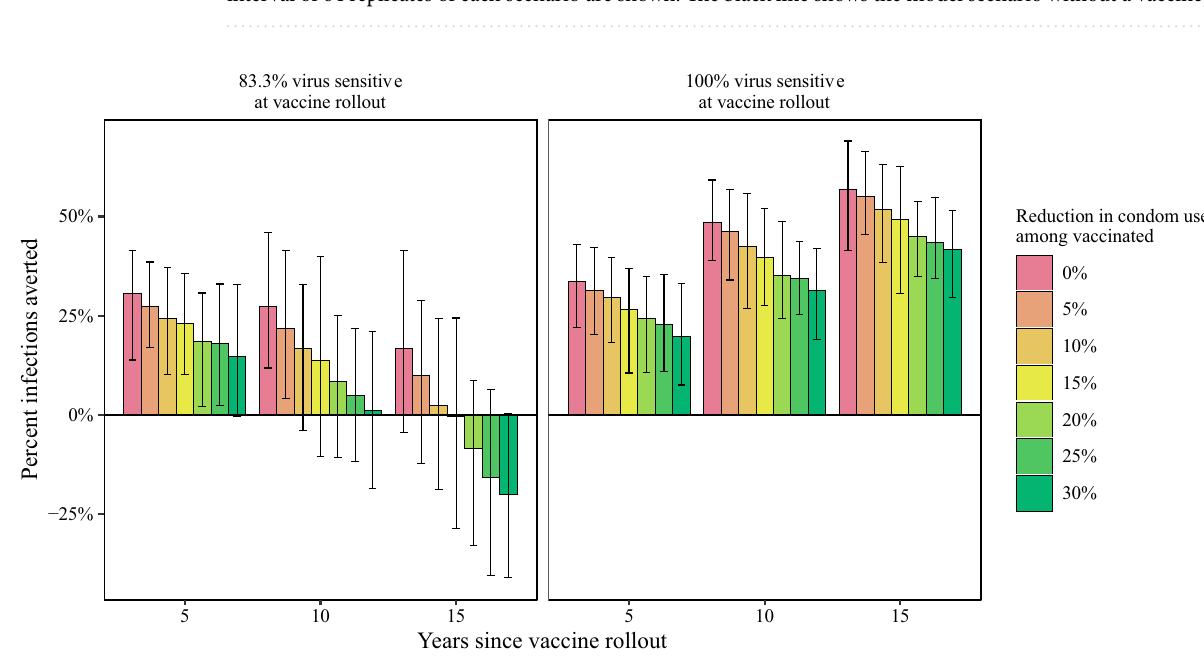
Figure 1. HIV-1 prevalence following introduction of a partially effective vaccine in the year 2018 (dashed vertical line), with 50% overall vaccine efficacy and 70% vaccine coverage (note that 50% overall efficacy can result from weighted combinations of efficacy and resistant strain frequency). Model scenarios shown include variation in the proportion of vaccine-sensitive virus at vaccine rollout (83% or 100%) and variation in the reduction in condom use among vaccinated individuals (from 0 to 30% reduction). The mean and 95% credible interval of 64 replicates of each scenario are shown. The black line shows the model scenario without a vaccine.